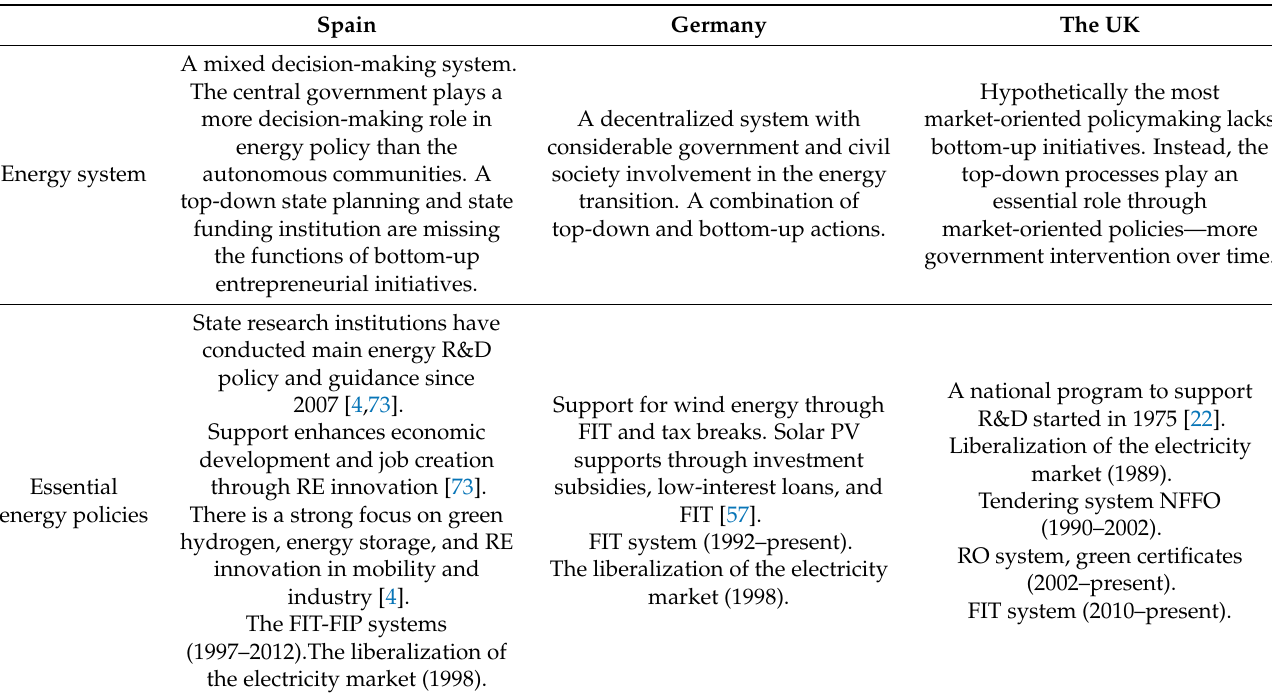
Table 2. Spain’s energy industry systems and policies (compared with Germany and the UK),